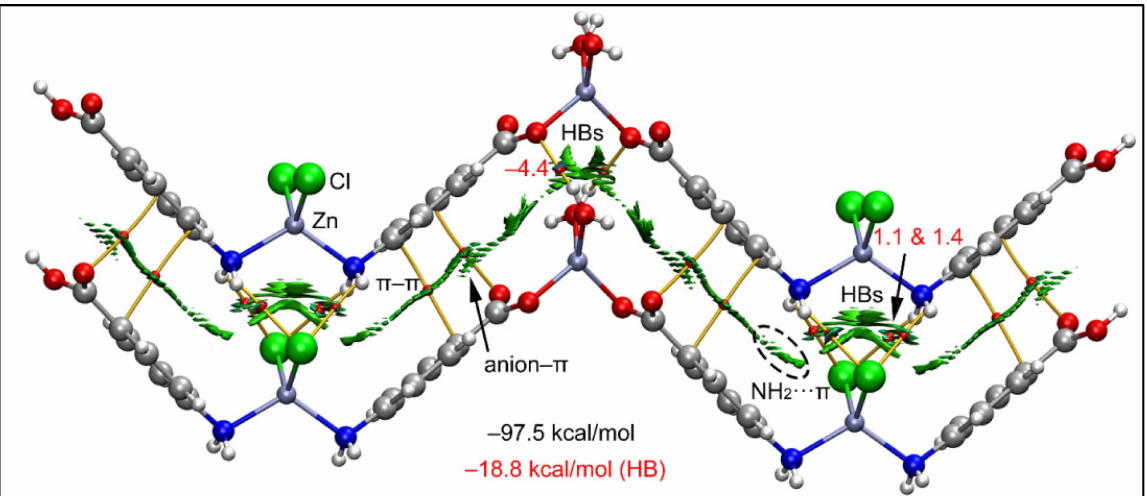
Figure 9. QTAIM (bond paths in orange and bond CPs in red) and RDG surface analyses of the model of compound 1 ; the gradient cut-off is (cid:36) = 0.04 a.u., s = 0.4, and the color scale is − 0.035 a.u. < (cid:36) < 0.035 a.u. The interaction energies are also indicated, computed at the RI-BP86- D3/def2-TZVP level of theory. Only intermolecular interactions are represented. The total contribu- tion of the H-bonds is also indicated, estimated using the Vr energy